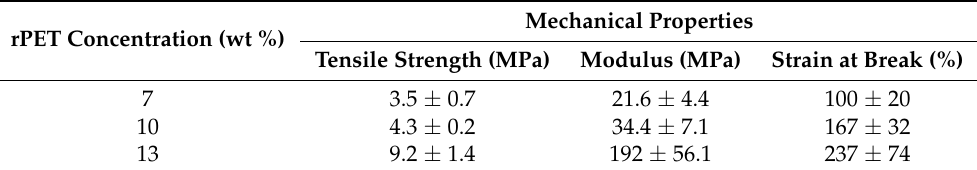
Mechanical Properties